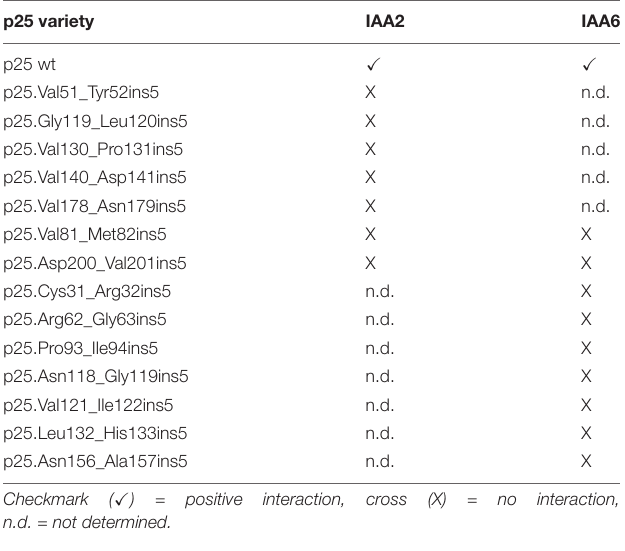
TABLE 1 | Results of the YTH assay of the p25 pentapeptide scanning mutants tested for interaction with IAA2 and IAA6. p25 variety IAA2 p25 wt